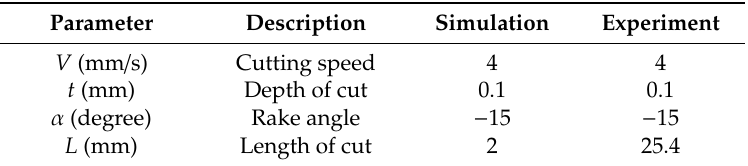
Figure 2. ( a )DEMmodelofthecuttingsimulation, ( b )experimentalsetupoftheorthogonalmachiningtest. Figure 2. ( a ) DEM model of the cutting simulation, ( b ) experimental setup of the orthogonal machining test. Table 3. Cutting conditions for the Table 3. Cutting conditions for the experiments.